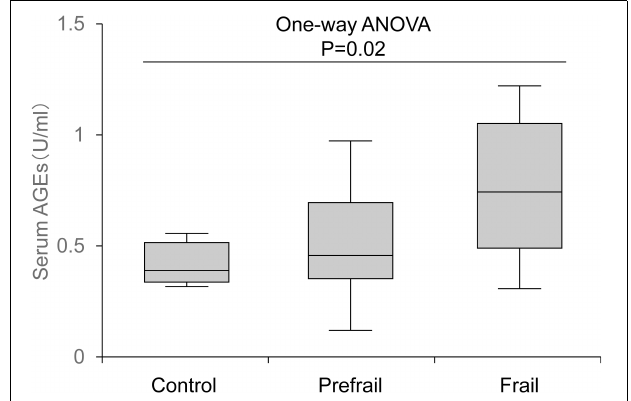
FIGURE 1 | Association between serum advanced glycation end product (AGE) levels and frailty status. AGE level increased according to the degree of frailty. The top and bottom regions of the boxes indicate 75 and 25 percentiles, respectively. The line through the middle of each box represents the median. The upper and lower error bars show minimum and maximum values, respectively (Yabuuchi et al., 2020).